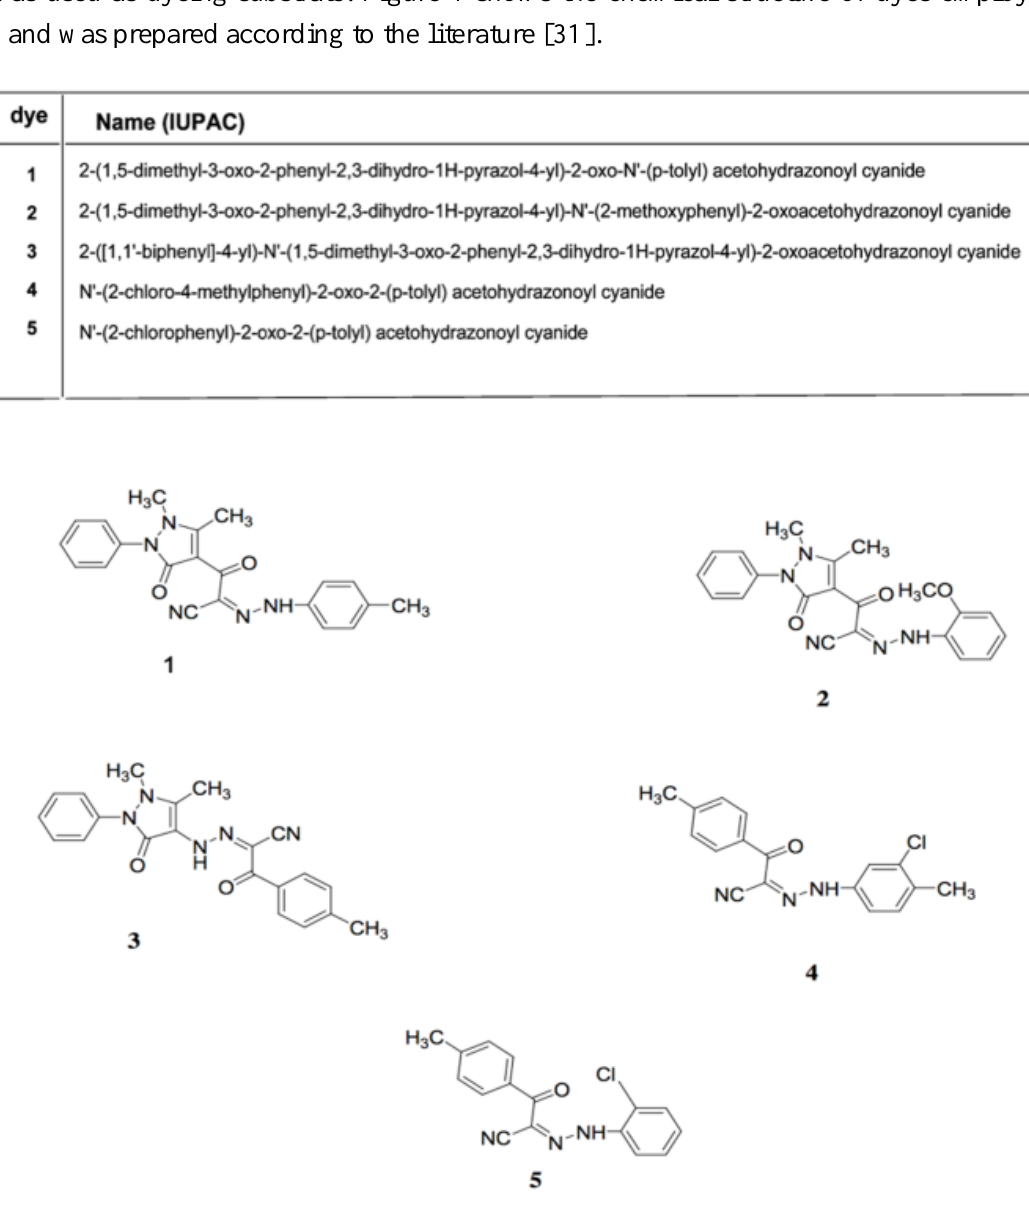
Figure 1. The chemical structure of